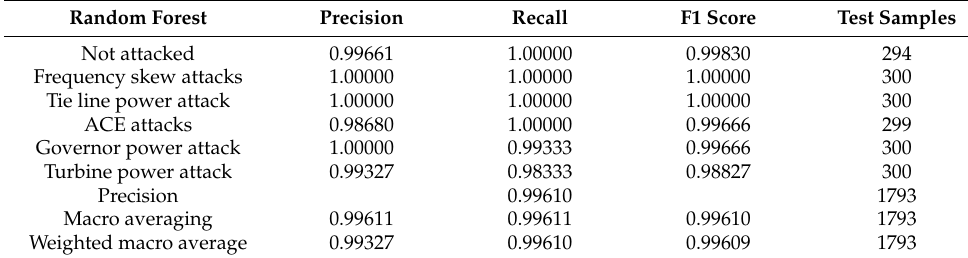
Table A1. The algorithm trained on the model metric data.